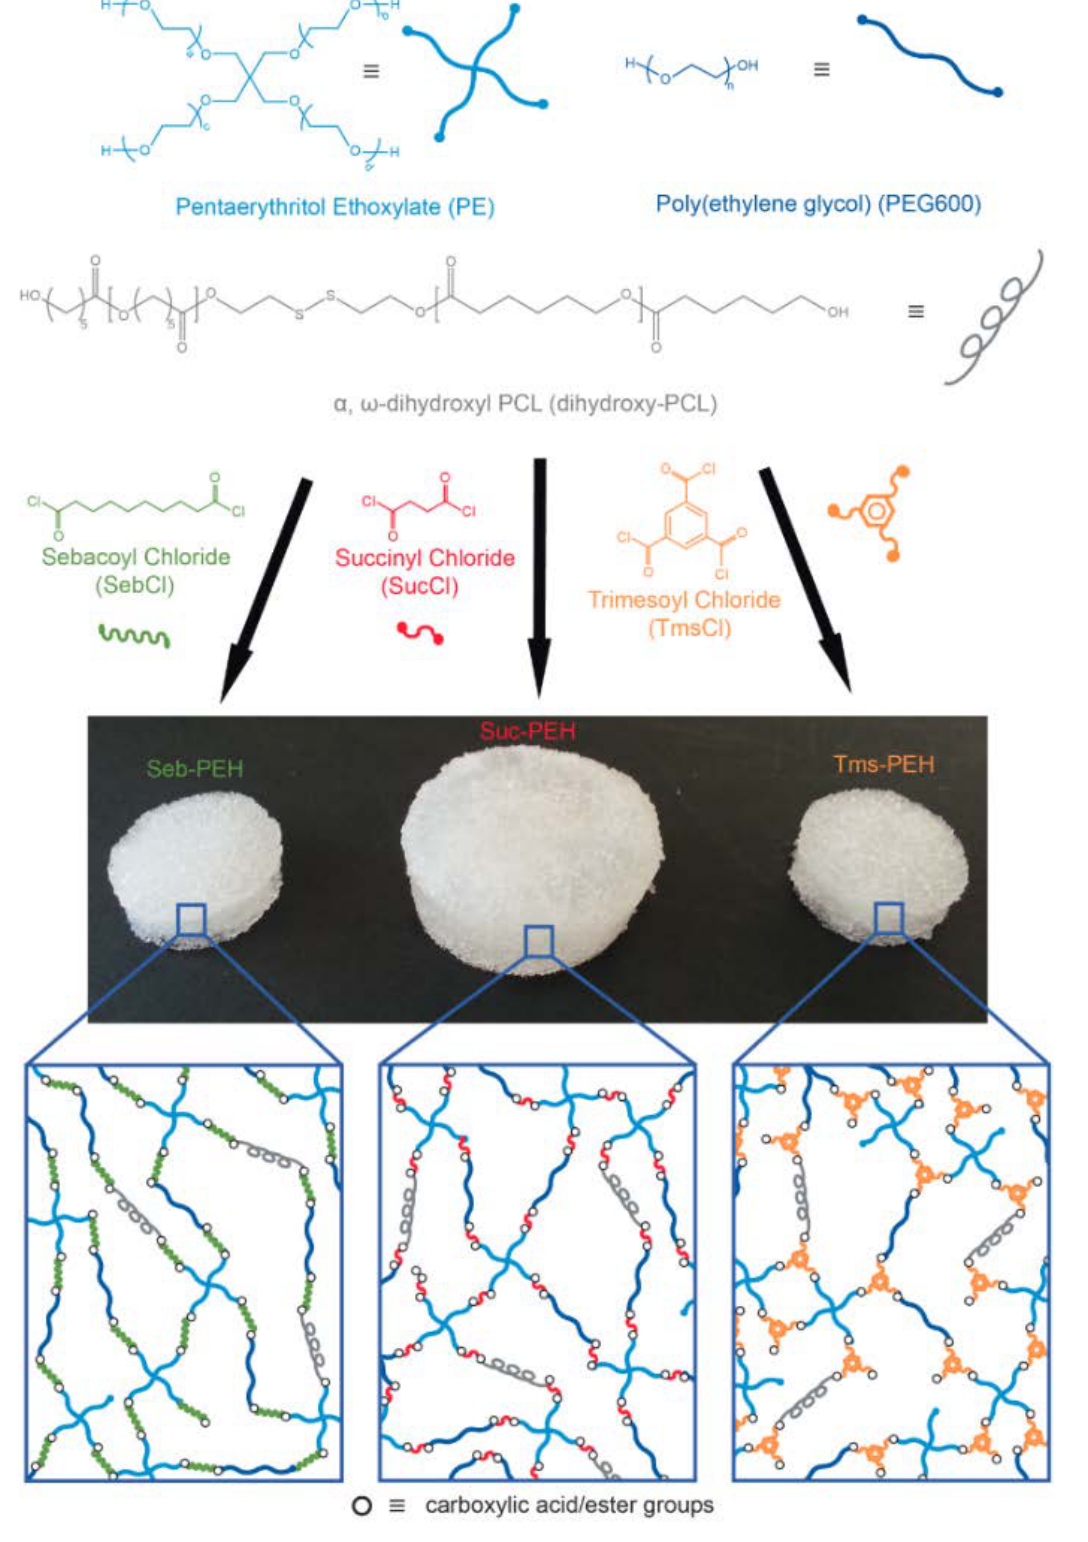
Figure 1. Synthesis of Suc-PEH # , Seb-PEH # , and Tms-PEH # and their representative network structures.